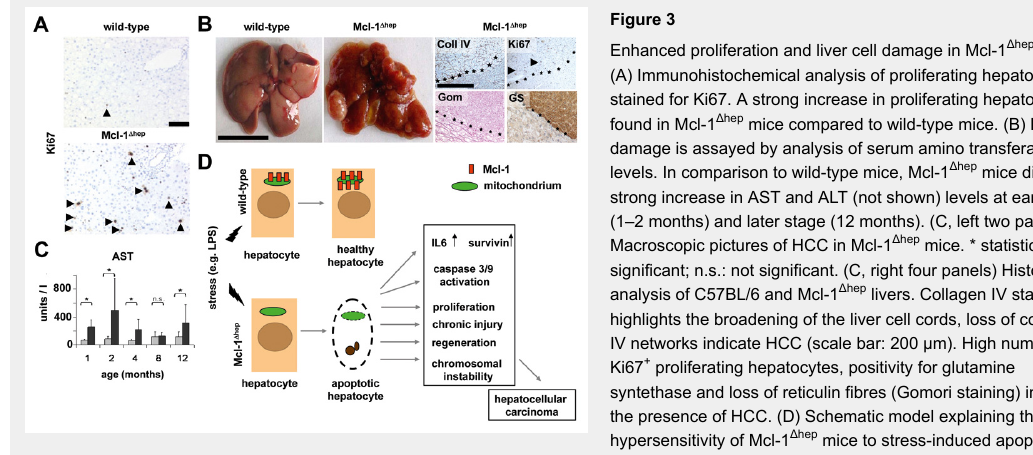
Enhanced proliferation and liver cell damage in Mcl-1 Δhep mice. (A) Immunohistochemical analysis of proliferating hepatocytes stained for Ki67. A strong increase in proliferating hepatocytes is found in Mcl-1 Δhep mice compared to wild-type mice. (B) Liver damage is assayed by analysis of serum amino transferase levels. In comparison to wild-type mice, Mcl-1 Δhep mice display a strong increase in AST and ALT (not shown) levels at early (1–2 months) and later stage (12 months). (C, left two panels) Macroscopic pictures of HCC in Mcl-1 Δhep mice. * statistically significant; n.s.: not significant. (C, right four panels) Histological analysis of C57BL/6 and Mcl-1 Δhep livers. Collagen IV staining highlights the broadening of the liver cell cords, loss of collagen IV networks indicate HCC (scale bar: 200 μm). High numbers of Ki67 + proliferating hepatocytes, positivity for glutamine syntethase and loss of reticulin fibres (Gomori staining) indicate the presence of HCC. (D) Schematic model explaining the hypersensitivity of Mcl-1 Δhep mice to stress-induced